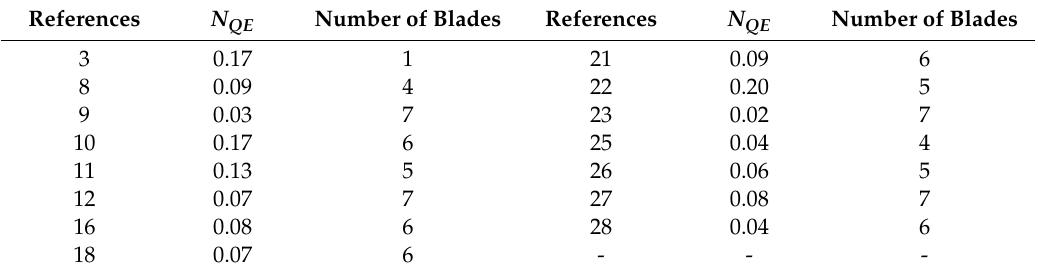
Table 1. Specific speed and number of blades of the study cases in the cited literature.